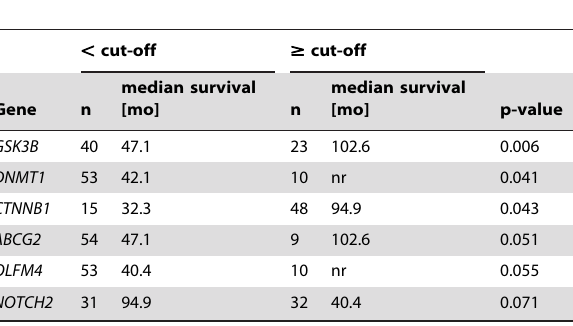
Table 3. Gene expression and association with survival – conditional inference